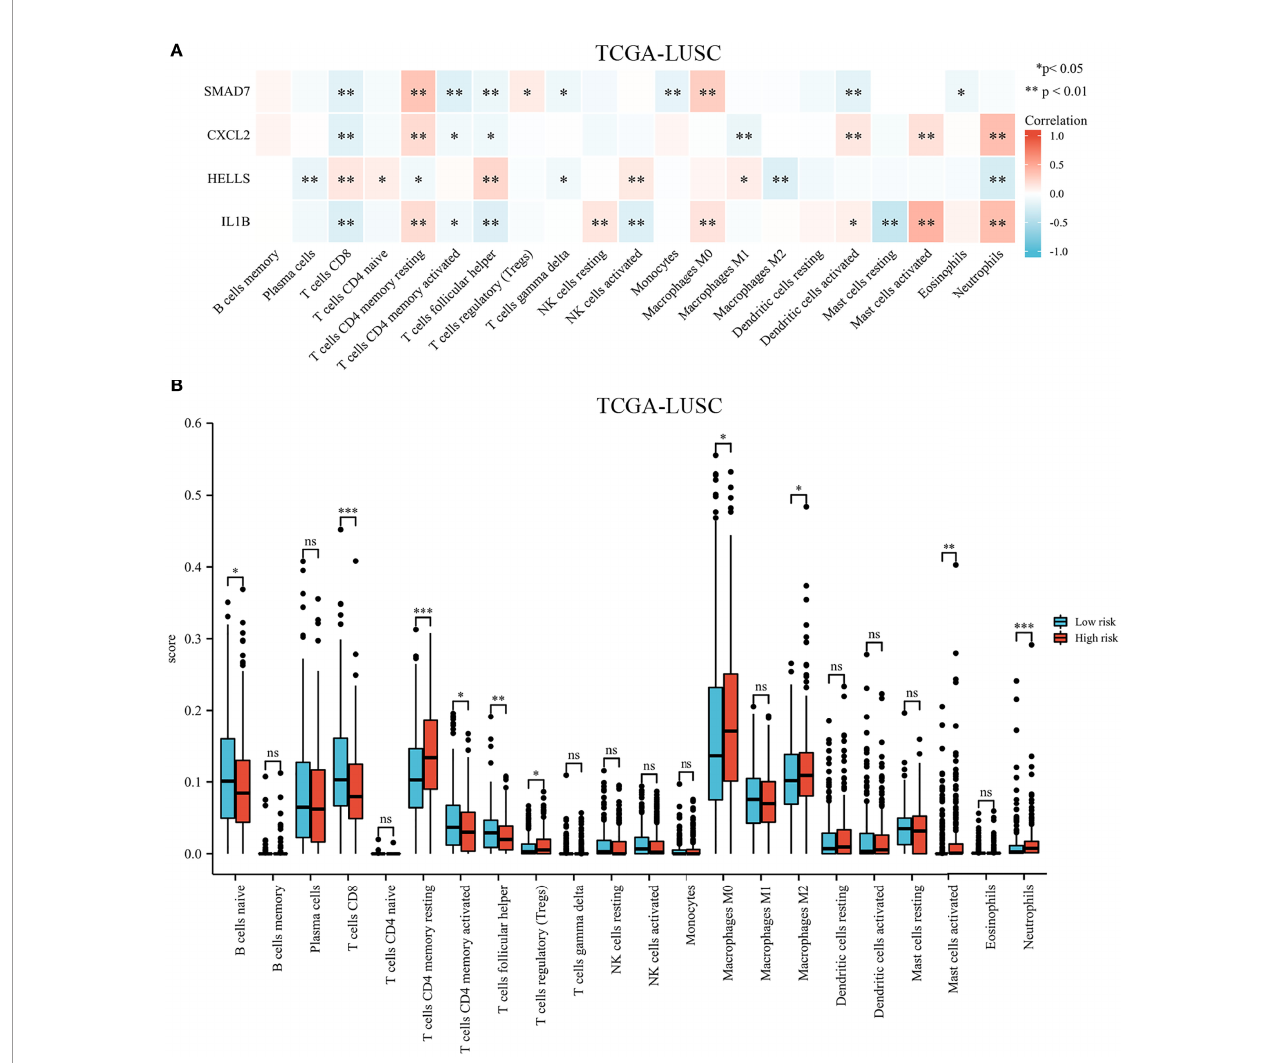
FIGURE 9 | Immune cell in fi ltration in different high- and low-risk groups in the TCGA cohort. (A) Heatmap of immune cell proportions. (B) The bar graph showing the difference between in fi ltrated immune cells in the tumor microenvironment. *p < .05, **p < .01, ***p < .001, and ns means not signi fi